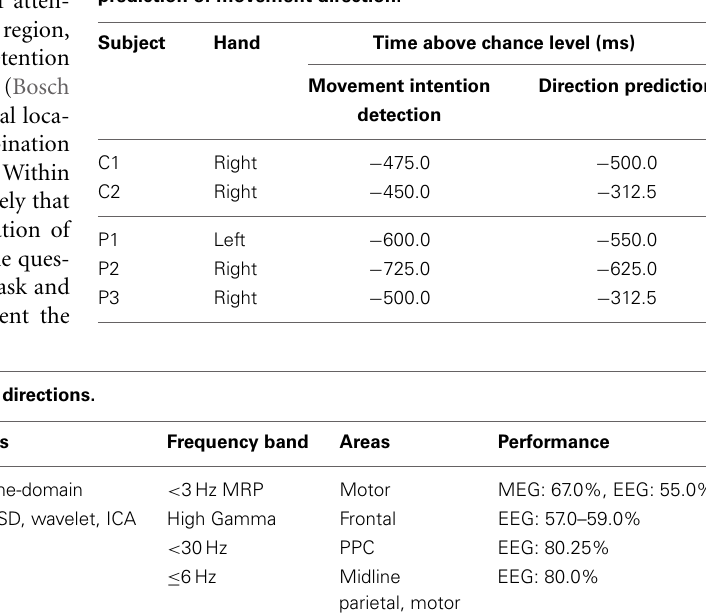
prediction of movement direction.